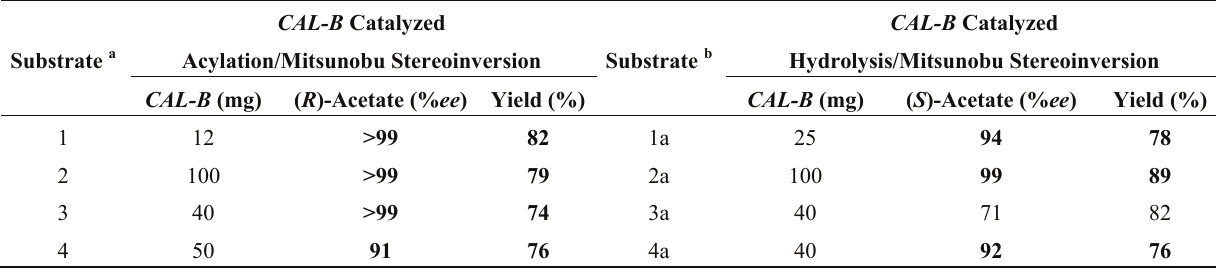
Table 3. Comparison of deracemization through acylation/inversion and hydrolysis/inversion processes. Substrate